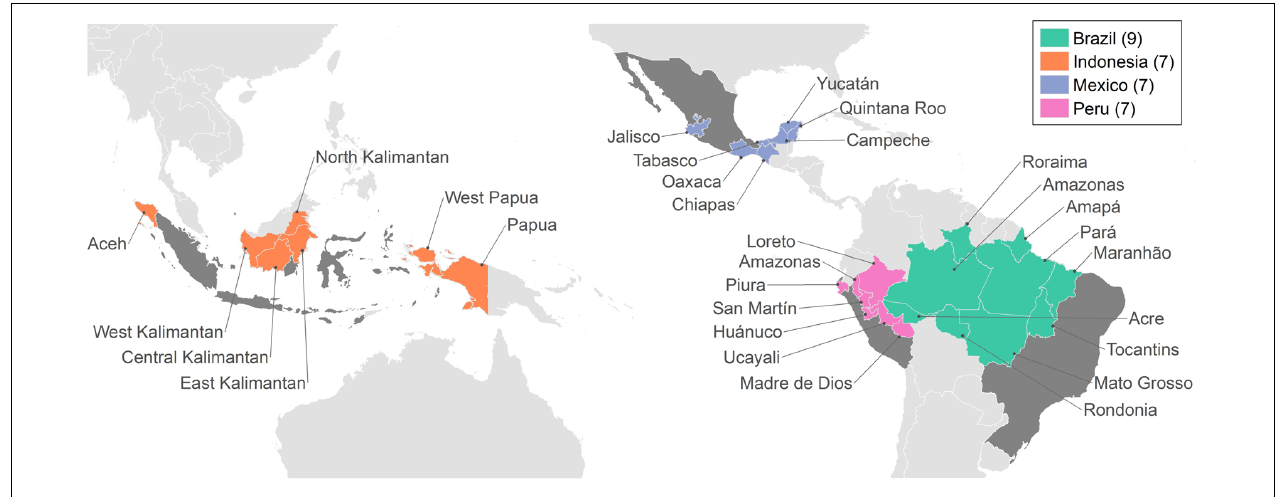
FIGURE 1 | Map of 30 study jurisdictions representing first-level subnational political and administrative divisions (e.g., provinces, states) in 4 tropical countries.